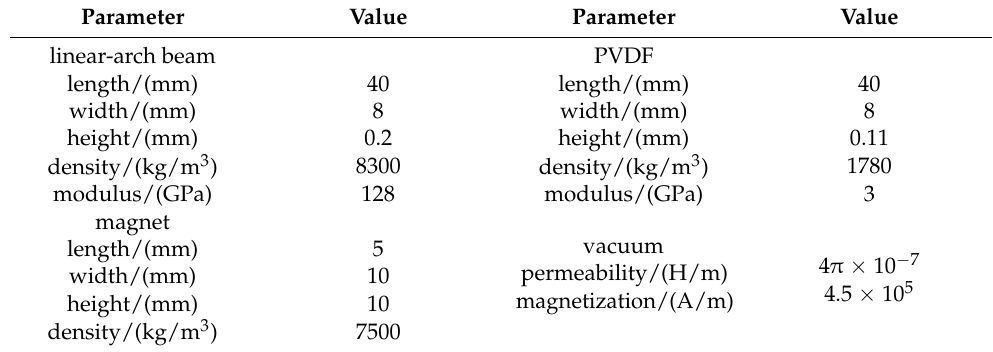
Table 1. Structure parameters of